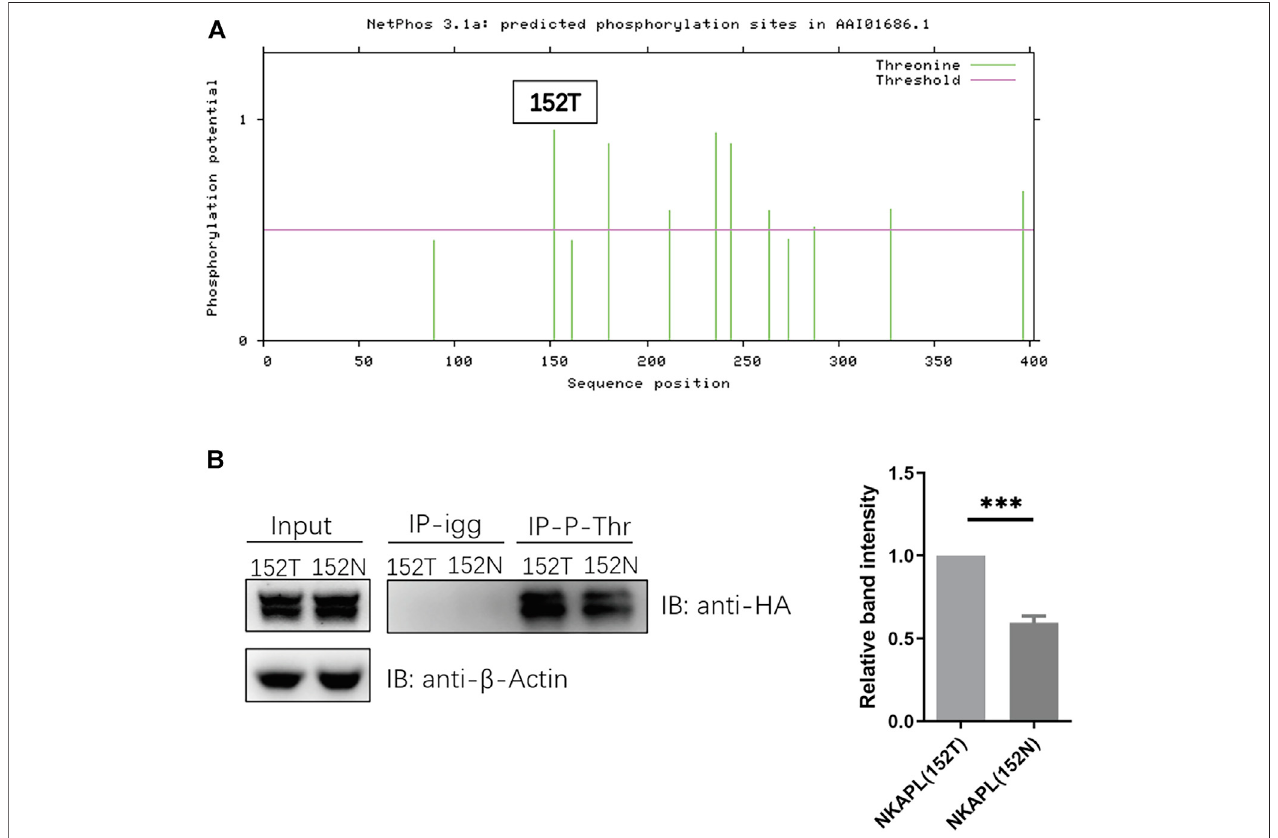
FIGURE 3 | Phosphorylation level of NKAPL-152N is decreased compared to NKAPL-152T. (A) Phosphorylation sites prediction using NetPhos 3.1 (https:// services.healthtech.dtu.dk/service.php?NetPhos-3.1). (B) The protein level of phosphorylated NKAPL is decreased in NKAPL-152N, and a signi fi cant decrease was shown by western blotting, n = 3 biological replicates in each group. Data were expressed as mean ± SEM, 2-tailed student ’ s t-test. ***P <